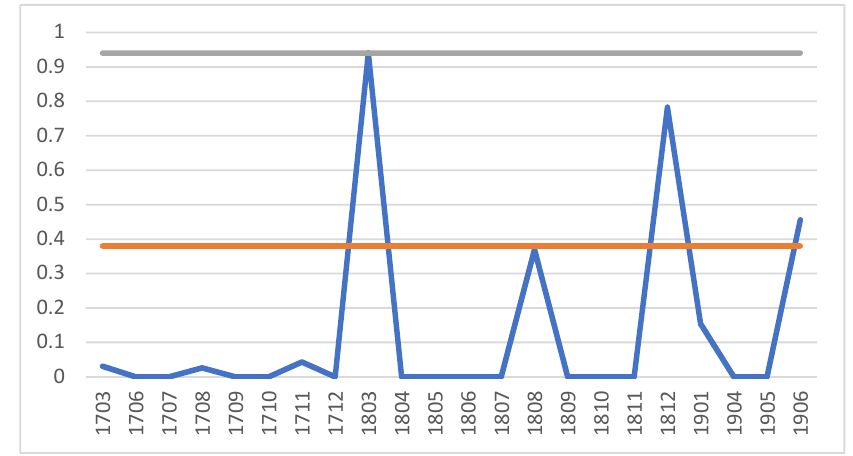
Figure 6. Keyword frequency of the antecedent “deposits”.